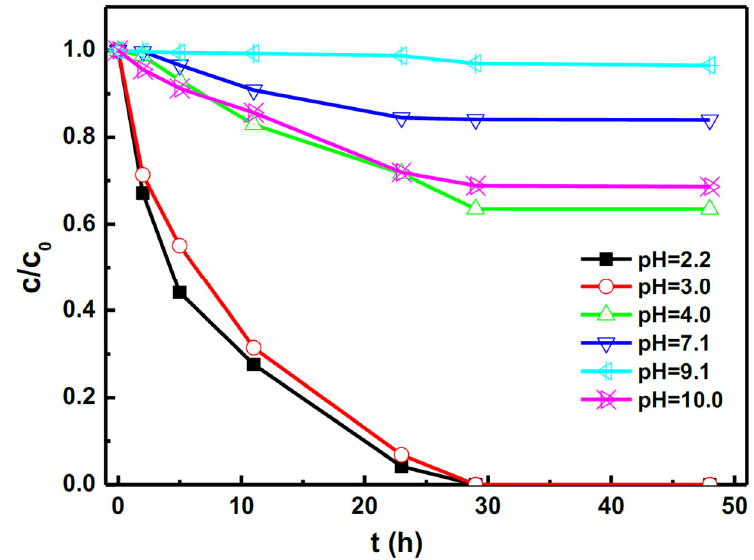
Figure 5. AuNPs sorption behavior on pyrite surface as a function of pH.